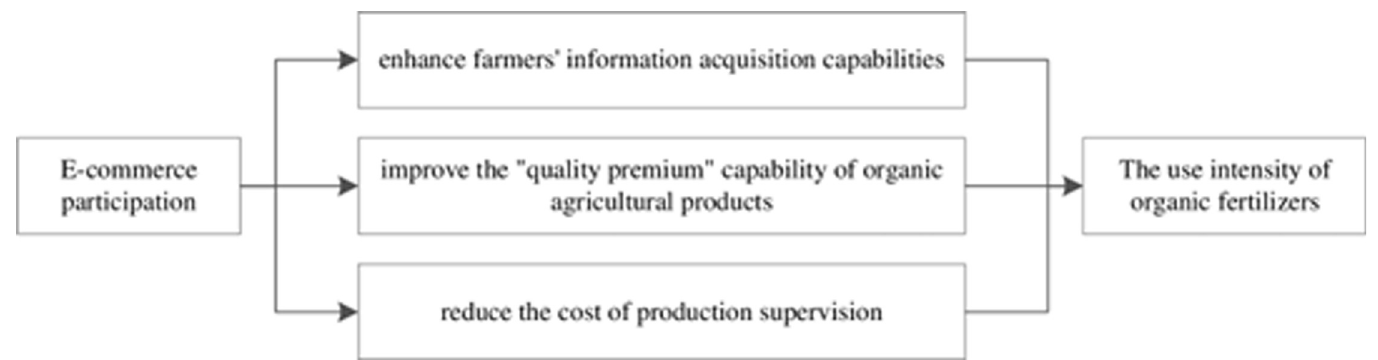
Fig 1. Pathways of E-commerce participation impacts on fruit farmers’ use intensity of organic fertilizers.